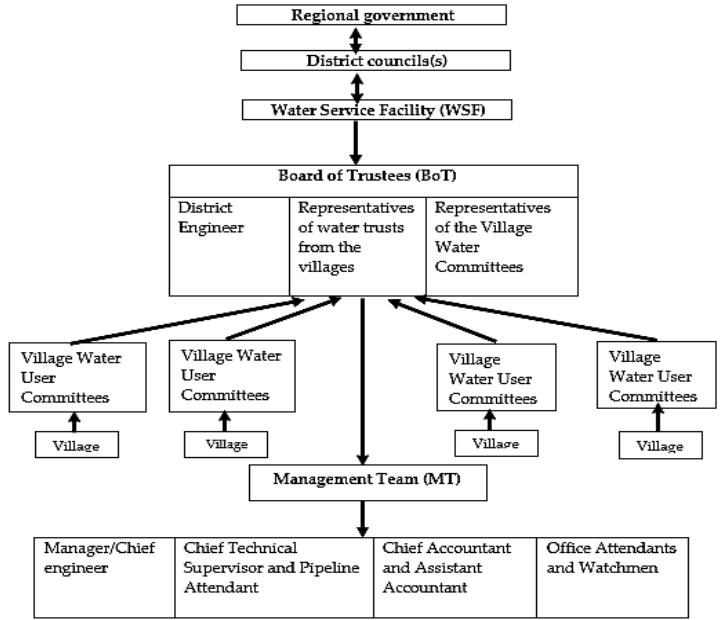
Figure 2. Organisational levels in the rural water supply in Hai and Siha (Source: Fieldwork data, 2017).